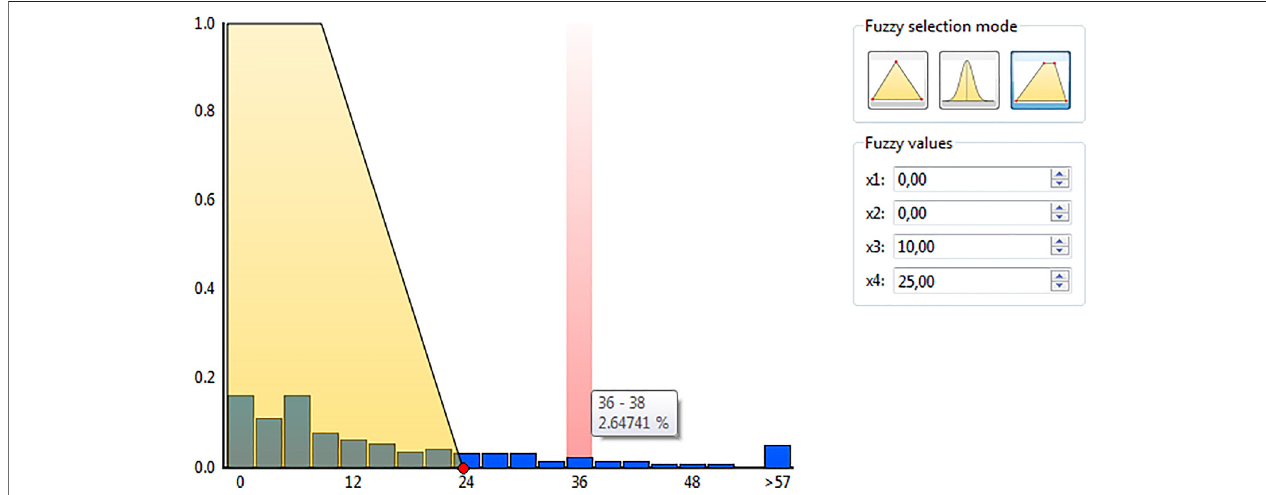
FIGURE 3 | Interactive selection by fuzzy fi ltering. The data context is given by a histogram (blue), along with some data details (at the column highlighted in light red). The user chose a trapezoid function for fuzzy selection, setting the four parameters x1 to x4 accordingly. The yellow area indicates the selection. Image: “ Speed fi lter ” by Höferlin et al. (2011) licensed under CC BY 3.0.